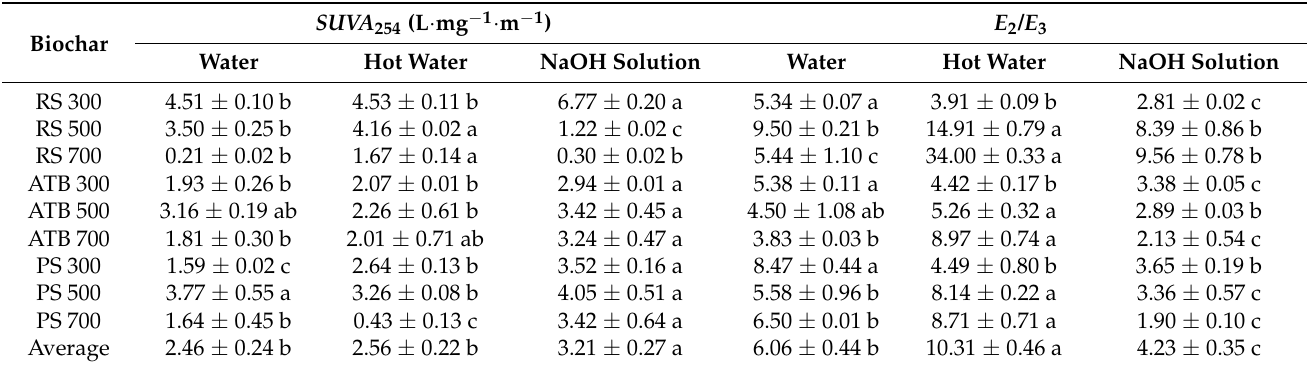
Table 3. The SUVA 254 (L · mg − 1 · m − 1 ) and E 2 / E 3 ratio of DOC released in water, hot water and NaOH solution ( n =